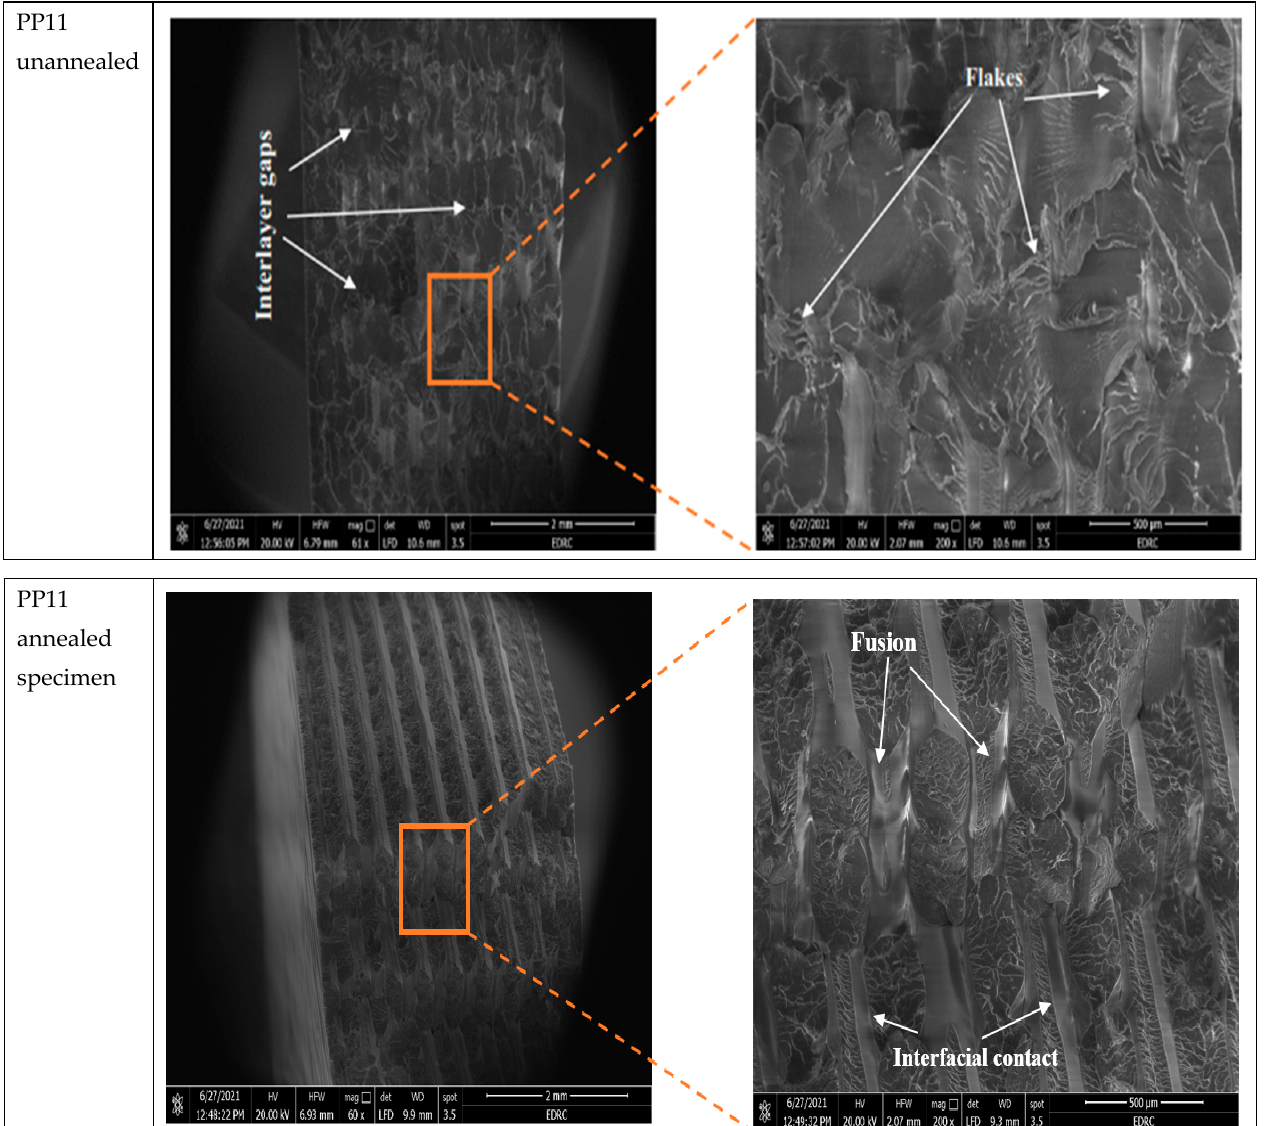
Figure 8. SEM photos and EDS plot of the effect of heat treatment over PP11 sample.